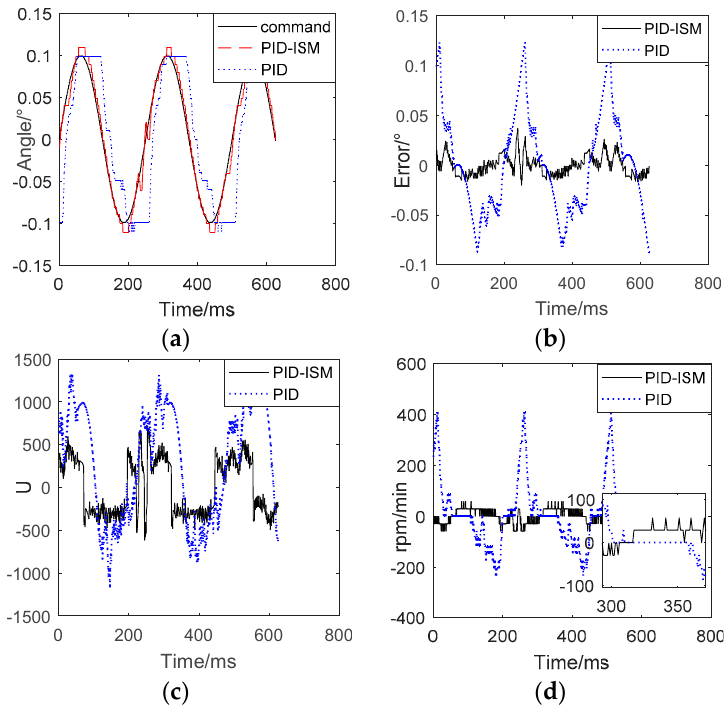
Figure 7. Position tracking (0.1°/4Hz) by using PID-ISM and PID. ( a ) Flat-top of position tracking. ( b ) Errors of position tracking. ( c ) The controller output of PID-ISM and PID. ( d ) The speed feedback by using PID-ISM and PID.